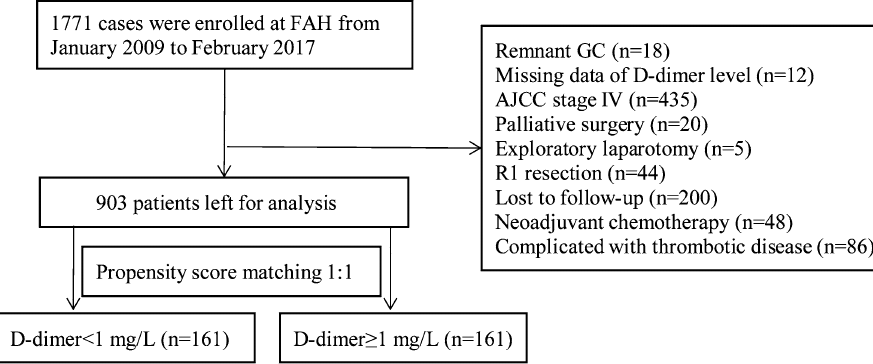
Figure 1. Flowchart with a summary of patient enrollment and propensity score matching. FAH, the First Affiliated Hospital of Xi’an Jiaotong